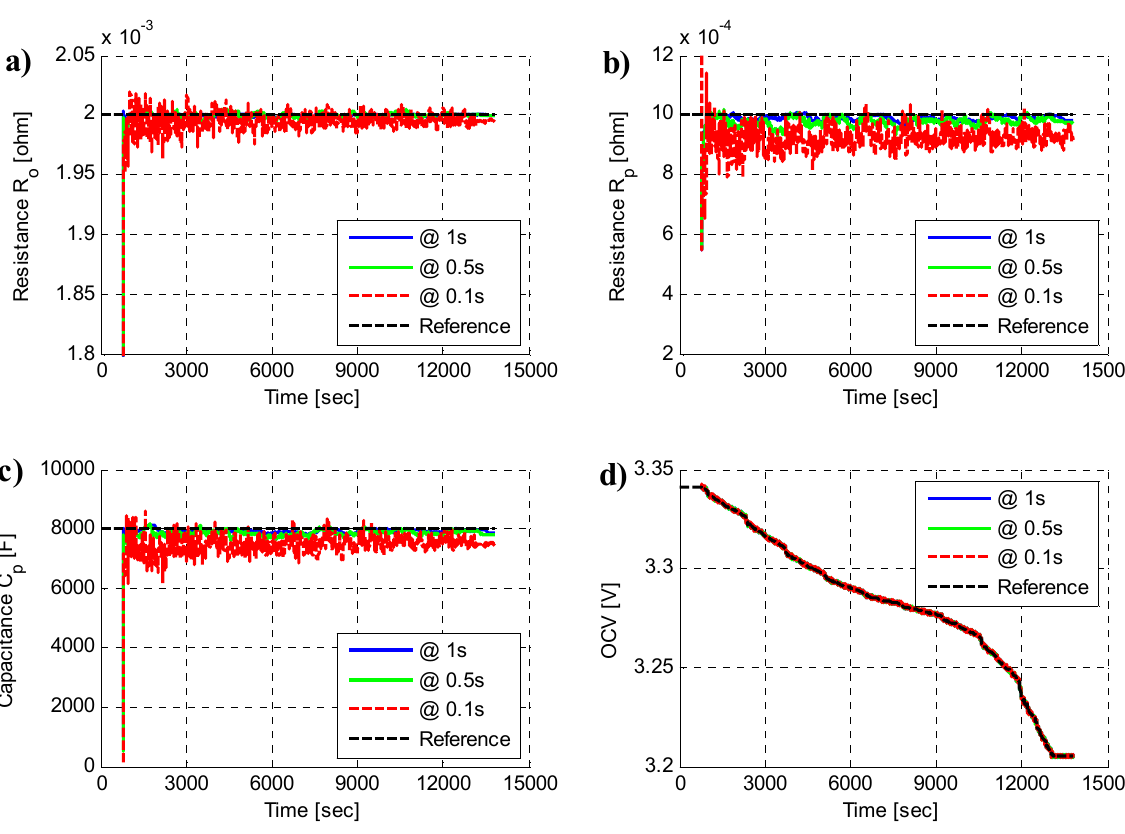
Figure 6. Estimated model parameters: ( a ) R o , ( b ) R p , ( c ) C p and ( d ) OCV at the sampling periods of 1/0.5/0.1